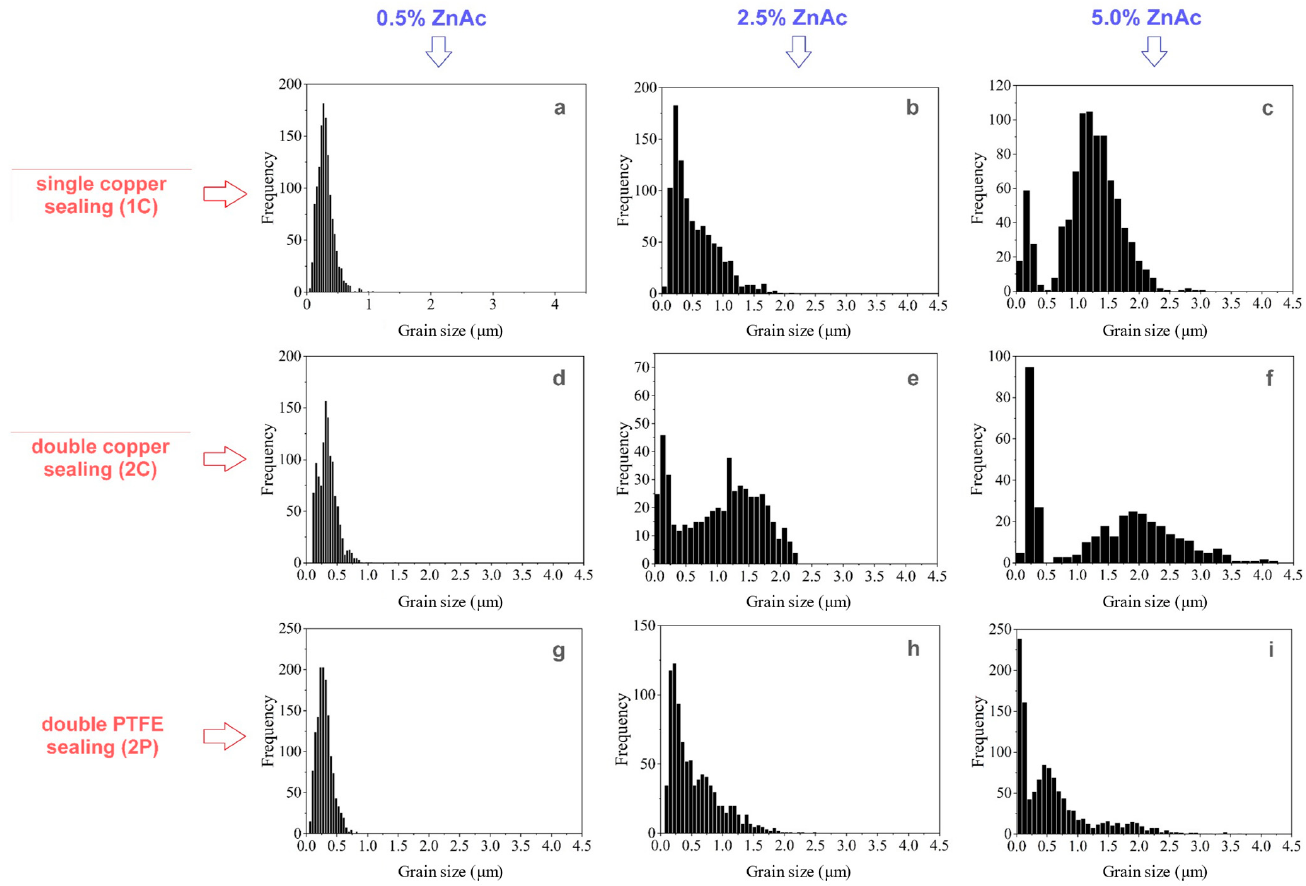
Figure 8. Grain size distributions of ceramics prepared from ZnO powder impregnated by 0.5 wt.% of ZnAc ( a , d , g ), 2.5 wt.% of ZnAc ( b , e , h ) and 5.0 wt.% of ZnAc ( c , f , i ) after CSP with the use of different types of sealing.